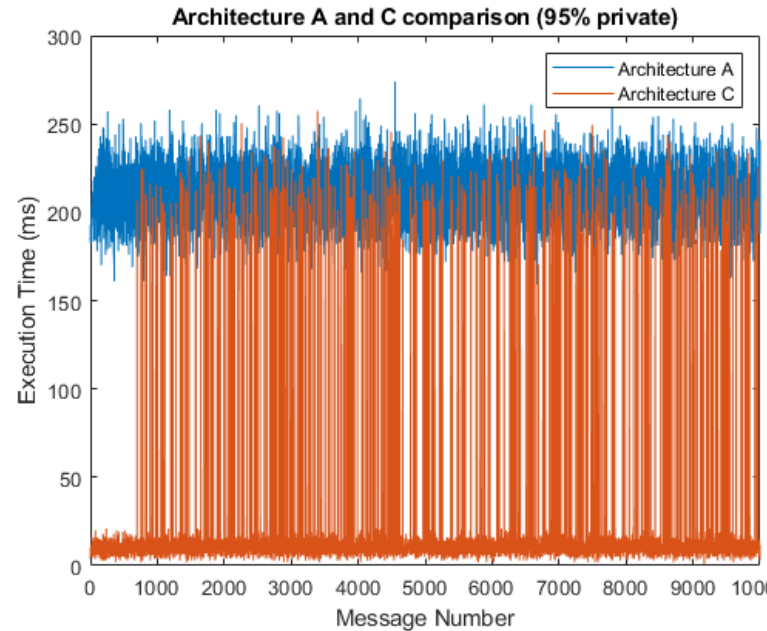
Figure 8. Comparison of architectures A and C (95% private messages).